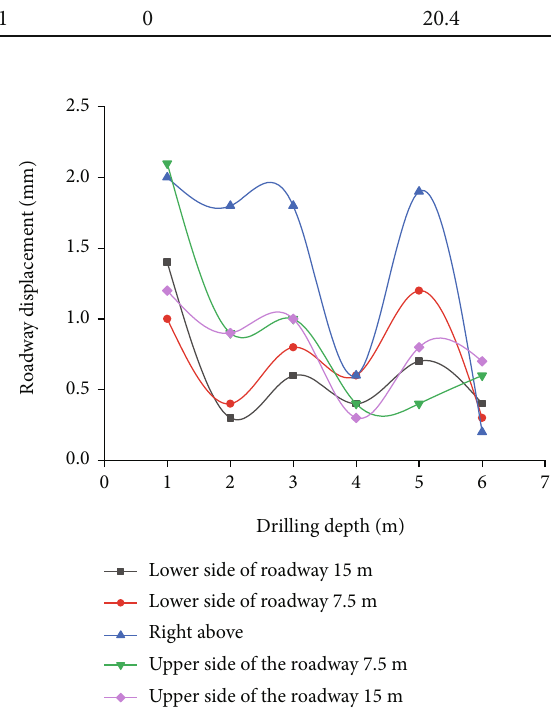
Figure 10: Displacement of surrounding rock in 213 fl oor roadway.